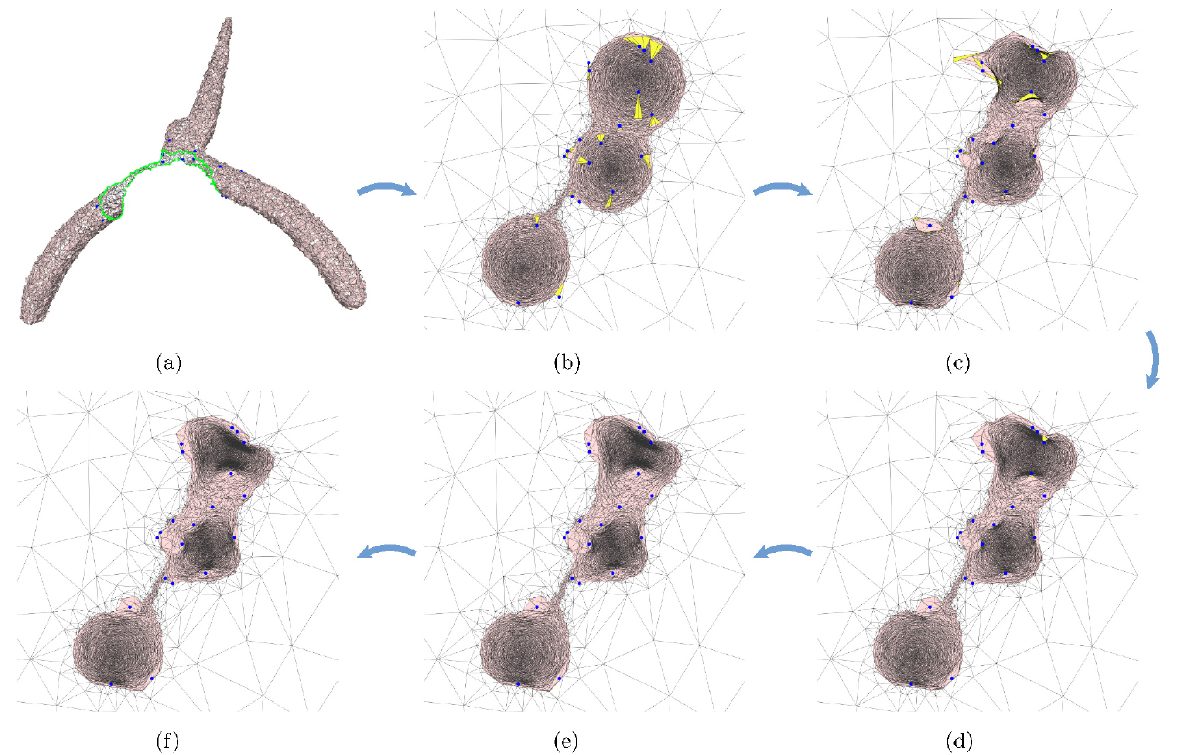
Fig. 5 Intermediate results when removing flips using Ref. [8]. (a) Input mesh. (b) Initialization. (c)–(f) Results after 4, 10, 25, and 41 iterations respectively. There are no flipped triangles in (f), so the remeshing step is not needed for this example.